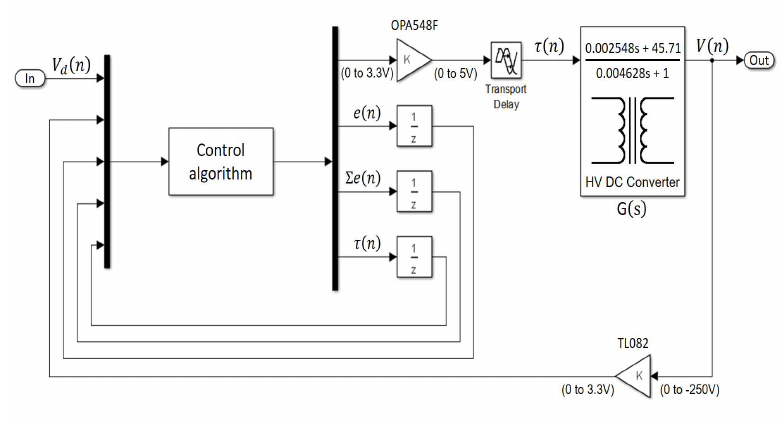
Figure 8. Experimental setup for the tuning process by simultaneous optimization of several responses